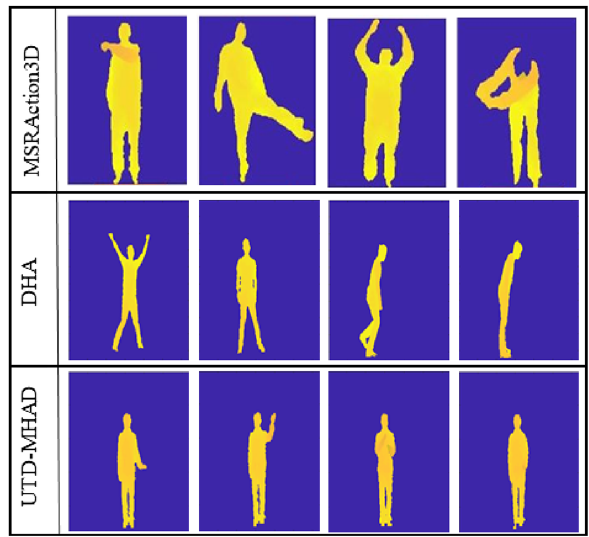
Fig. 8 Action snaps of MSRAction3D, DHA and UTD-MHAD